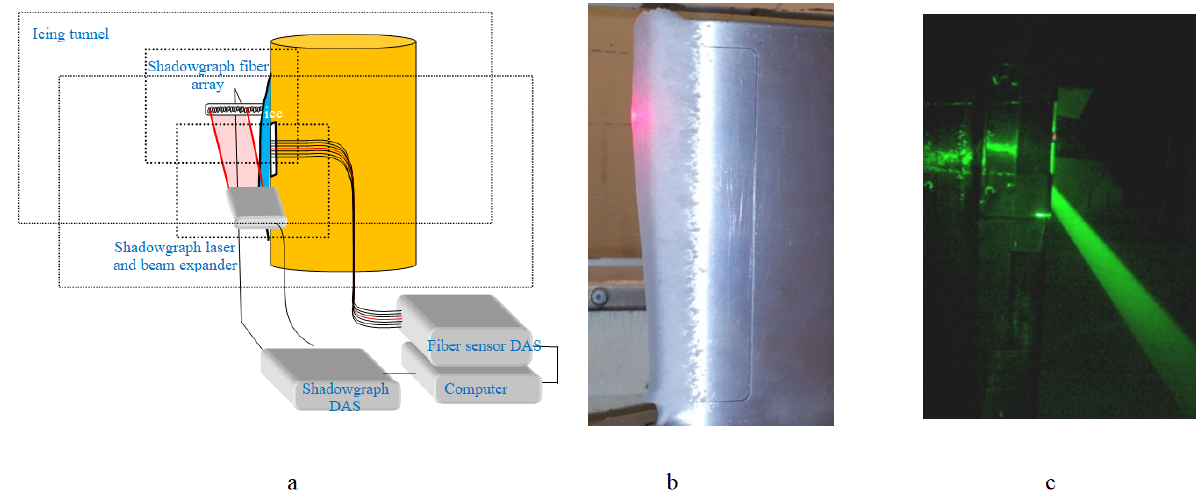
Figure 4. ( a ) Schematic diagram of experimental set up in icing tunnel. ( b ) Wing with ice in icing tunnel. ( c ) Shadowgraph beam in icing tunnel.